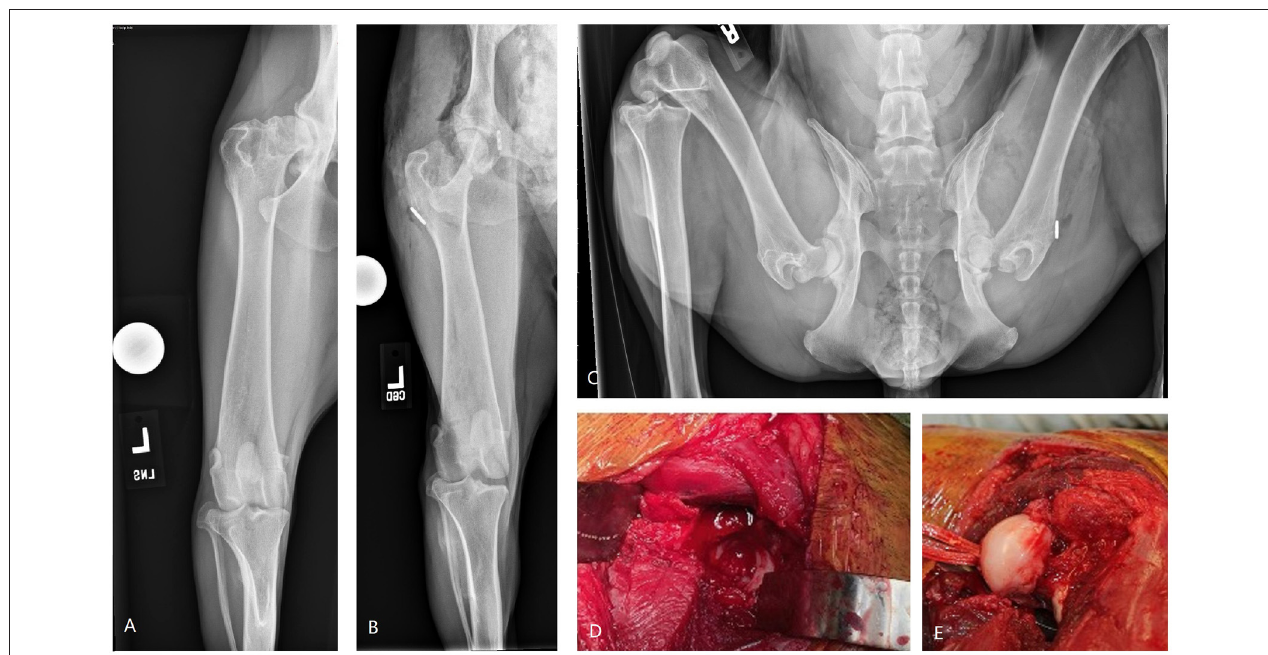
FIGURE 5 | Images of bipolar osteochondral allograft transplantation to treat end-stage coxofemoral osteoarthritis. (A) Pre-operative radiograph, (B,C) immediate post-operative radiographs, (D) acetabular OCA placement; (E) femoral head OCA placement with toggle pin construct to maintain femoral head reduction. This dog suffered femoral neck fracture and was revised with a femoral head and neck excision and was classified as having a major complication and unacceptable